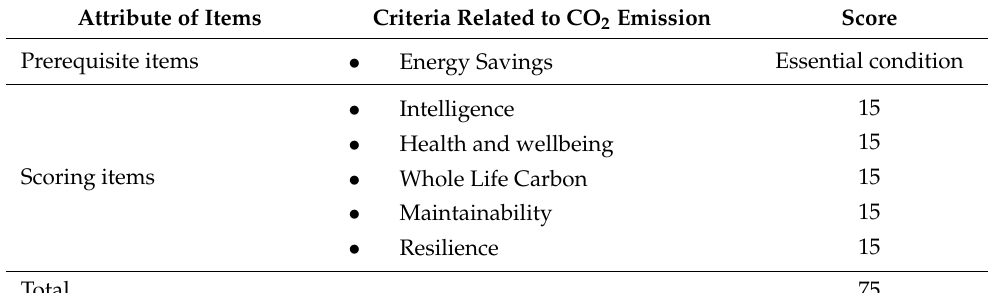
Table 4. Criteria of